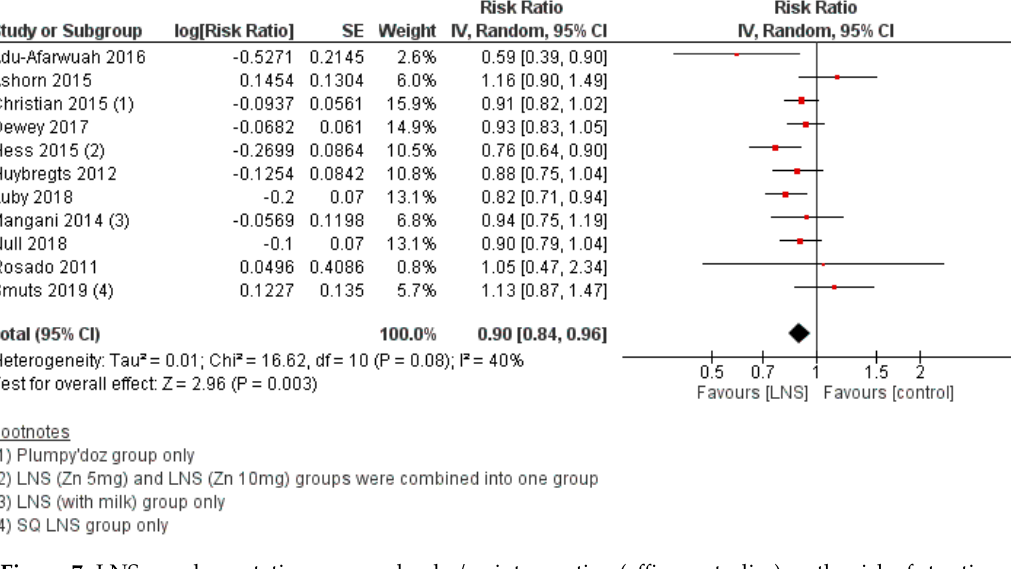
Figure 7. LNS supplementation versus placebo/no intervention (efficacy studies) on the risk of stunting (length-for-age z-score < − 2).